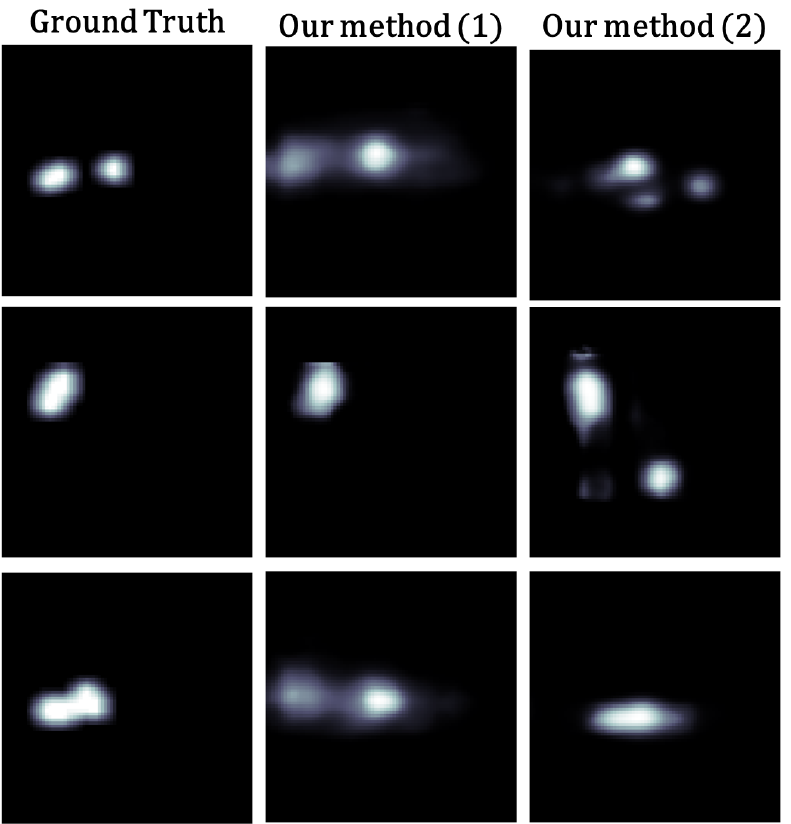
Figure 3. Example of ground truth y t and estimated saliency map y p for the model trained with our dataset with (1) and without (2) considering the adversarial